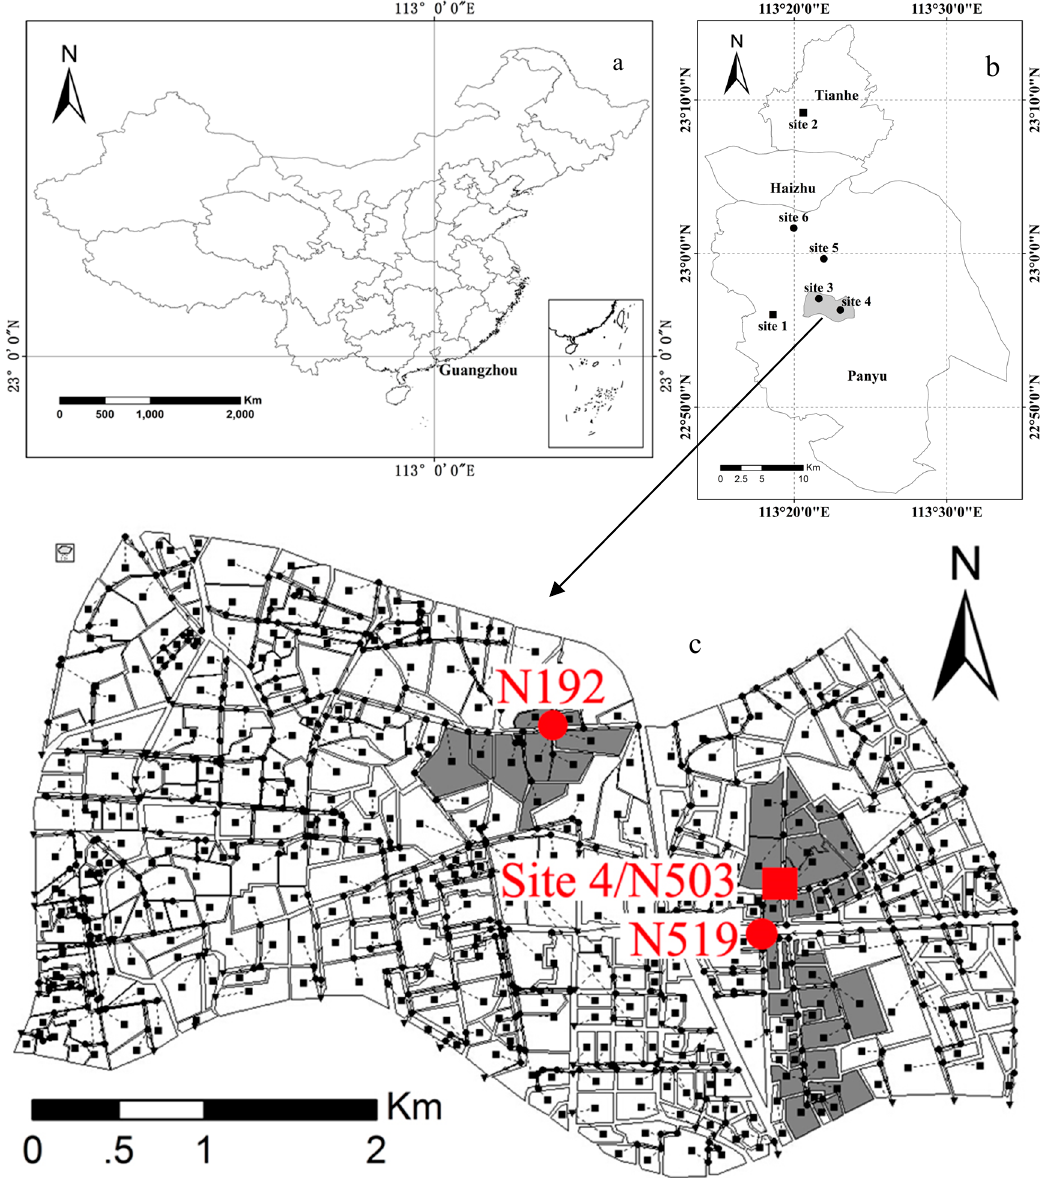
Figure 1. The locations of Guangzhou ( a ); meteorological sites ( b ); and the three selected nodes and their catchment area/ modeling areas by SWMM in Panyu District ( c ). Street flooding water depth is recorded near Site 4/Node 503 by a wireless electronic water depth meter.